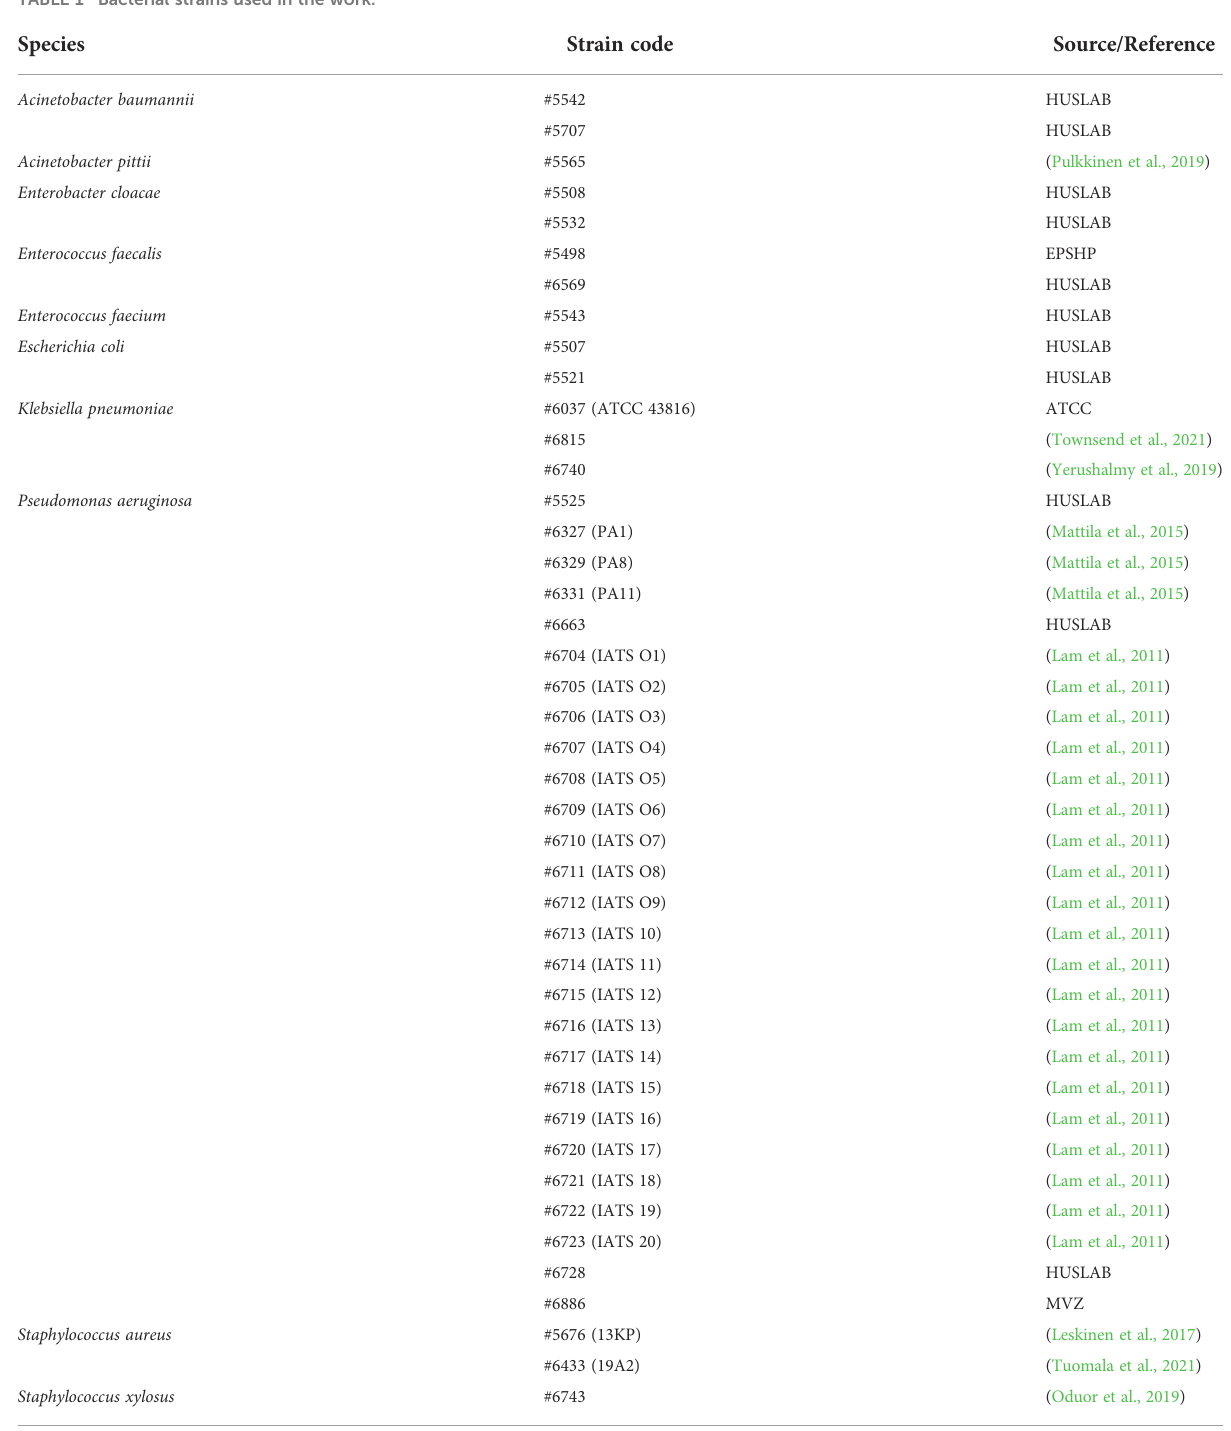
TABLE 1 Bacterial strains used in the